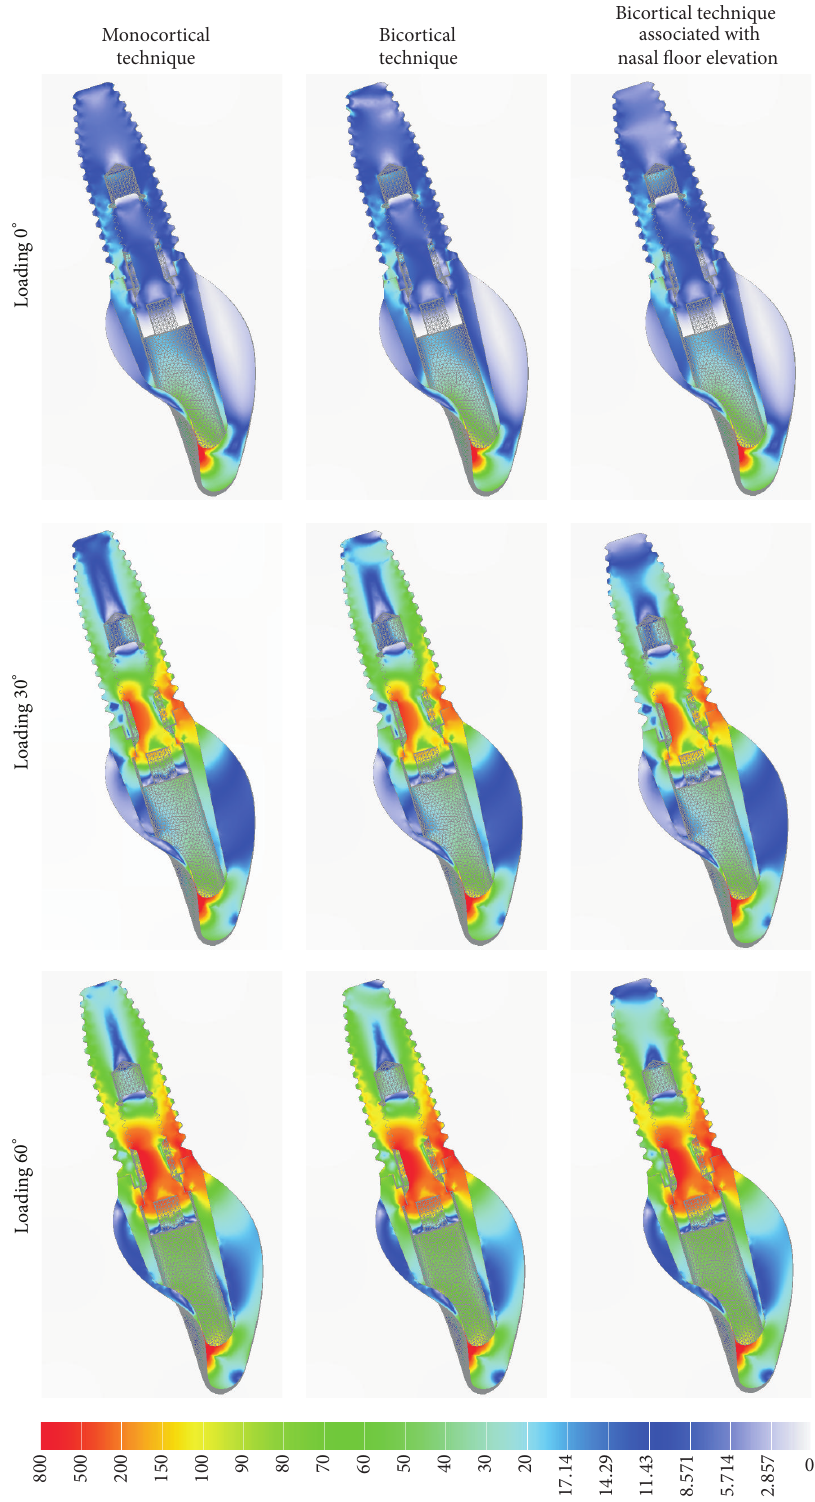
Figure 2: The von Mises stress analysis of implant, UCLA, crown, and screw fixation in sagittal view for different